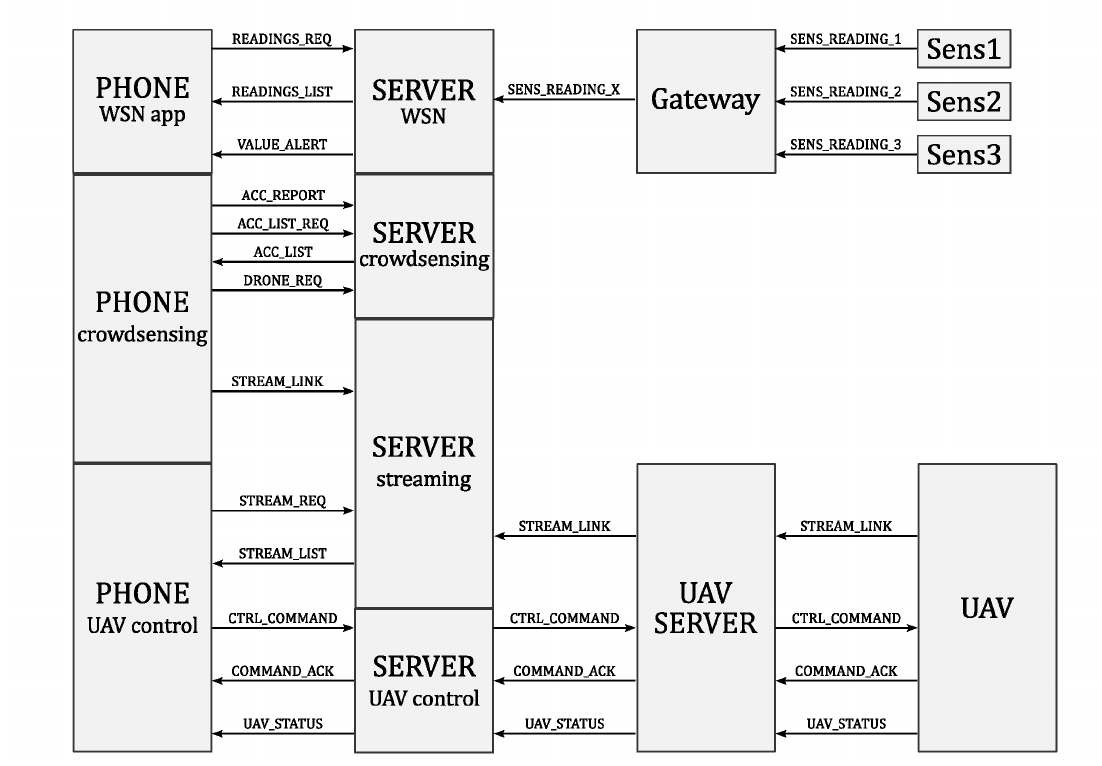
Figure 14. Web server